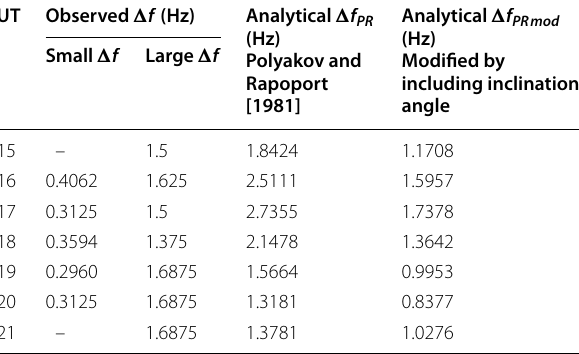
Table 1 Comparison between the frequencies separation obtained from observations of double spectral resonance structures observed on December 4, 2018 and from analytical